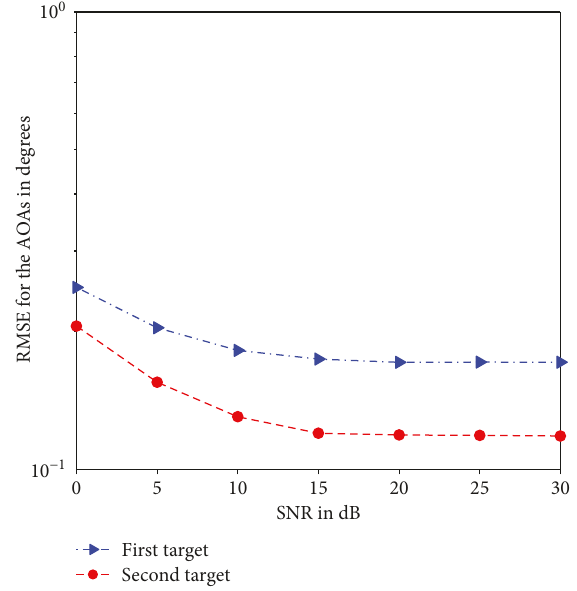
Figure 2: Root mean square error for the AOA in degrees vs. SNR in dB for γ = 0 4